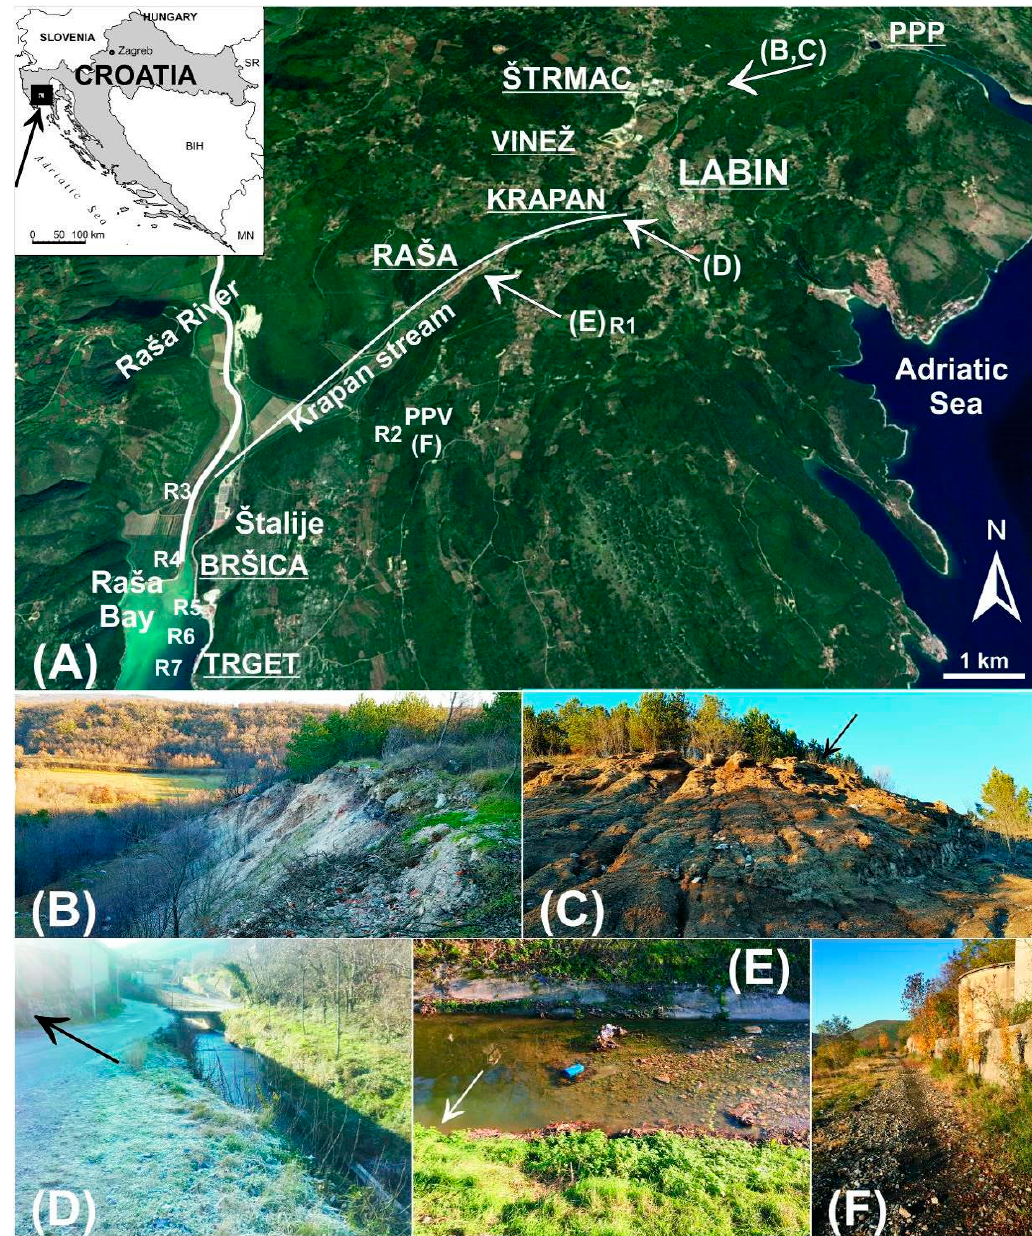
Figure 1. Map of the study area: ( A ) geographical position and sampling location names. Letters in parentheses refer to the relevant parts of the figure. Abbreviations are as follows: PPP—Plomin power plant, PPV—Vlaška power plant; ( B ) side view of the Štrmac location (ash waste pile); ( C ) front view of the Štrmac location (the arrow indicates a soil sampling site); ( D ) water sampling site (Krapan stream in the town of Krapan), the arrow shows the position of a chrome plating factory; ( E ) water sampling site (Krapan stream in the city of Raša), the arrow shows the position of municipal wastewater effluent; and ( F ) soil sampling site near PPV. Symbols R1–R7 designate water sampling sites of the 2018 campaign (details described in method chapter).